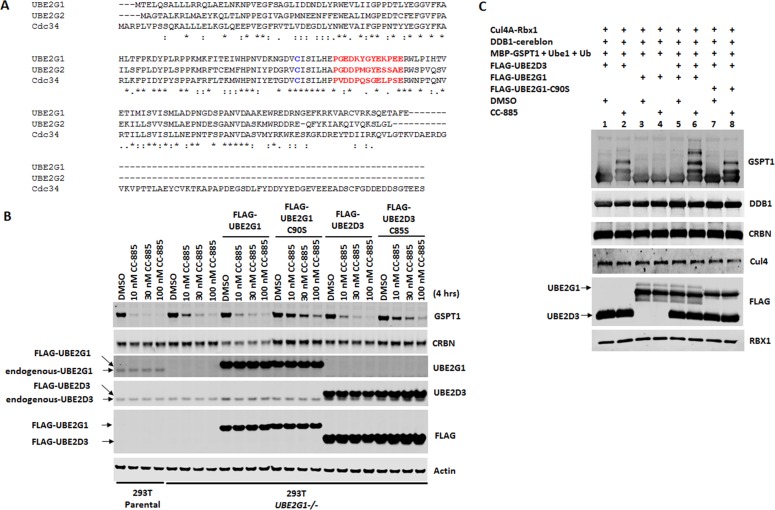
UBE2G1 catalyzes the ubiquitin chain assembly on GSPT1 pre-conjugated with ubiquitin.(A) Sequence alignment of human UBE2G1, human UBE2G2 and human CDC34 using Clustal W 2.1. The acidic loops indispensable for the assembly of K48-linked ubiquitin chains are highlighted with red, and the catalytic cysteines are highlighted with blue. (B) Immunoblot analysis of 293T parental or UBE2G1-/- cells transduced with lentiviral vectors expressing FLAG-tagged UBE2G1 wild-type or C90S mutant, or FLAG-tagged UBE2D3 wild-type or C85S mutant. Cells were treated with CC-885 at the indicated concentrations for 4 hr. Note that overexpression of wild-type FLAG-UBE2G1 or FLAG-UBE2D3 partially rescued the GSPT1 degradation defect caused by UBE2G1 deficiency, while overexpression of catalytically-dead mutant FLAG-UBE2G1-C90S or FLAG-UBE2D3-C85S further blocked the degradation of GSPT1. (C) In vitro ubiquitination of GSPT1 by CRL4CRBN with or without CC-885 and indicated E2 variants. Consistent with results observed with bacterial recombinant UBE2G1 and UBE2D3 proteins, FLAG-UBE2G1 and FLAG-UBE2D3 proteins purified from human cells acted in concert to promote the ubiquitination of GSPT1. Results shown in (B) and (C) are representative of three independent experiments.